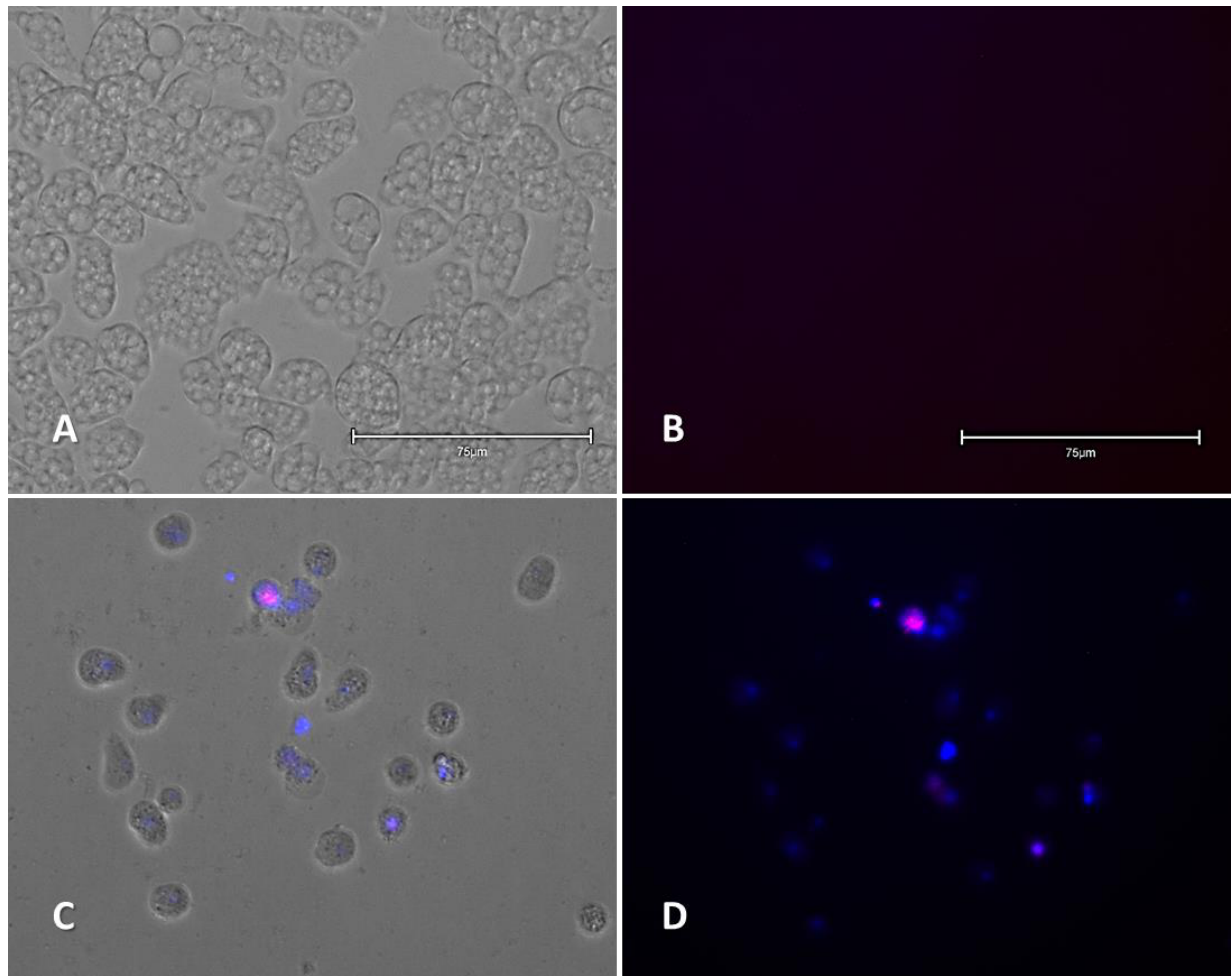
Figure 4. Naegleria fowleri (ATCC ® 30808™) trophozoites incubated with IC 90 of the evaluated compound 3 for 24 h. Negative control ( A – B ); compound 3 ( C – D ). Hoechst/PI stain is different in control cells, where no fluorescence is observed ( B ), and in treated cells, where the nuclei are intense blue and one of them shows red fluorescence inside ( D ). Images (40 × ) are representative of the cell population observed in the performed experiments. Images were obtained using an EVOS™ M5000 Imaging System, Invitrogen by Thermo Fisher Scientific, Madrid, Spain. Scale bars represent 75 µ m. Plasmatic membrane damage was caused by the selected compound after IC 90 incuba- tion for 24 h. Intense green fluorescence could be observed inside cells (Figures 5 and